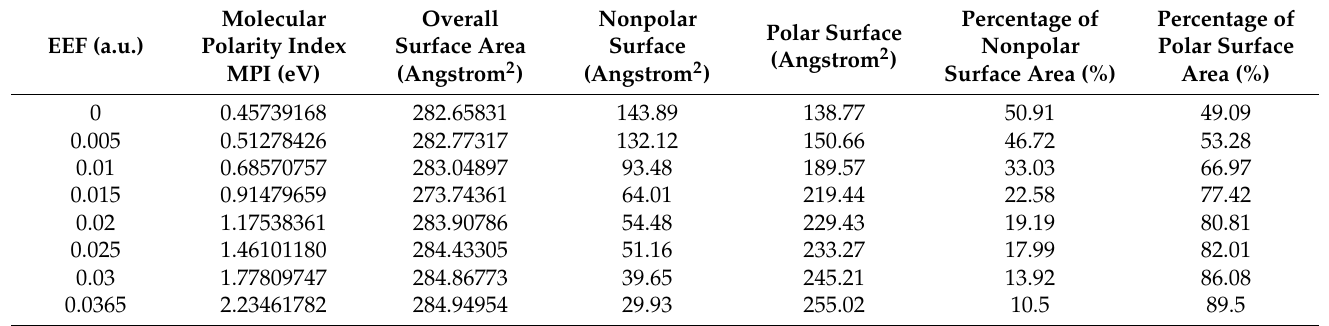
Table 2. Parameters such as MPI index, unpolarized area, and polarized area under different electric fields.